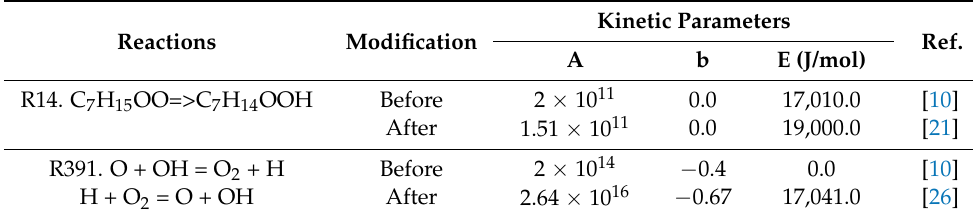
Table 2. Modified key reactions and kinetic parameters.